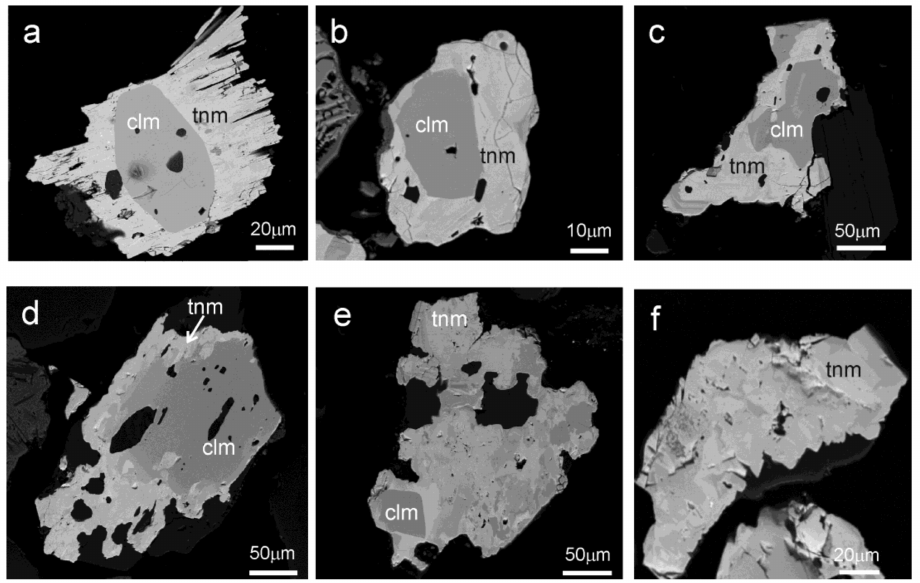
Figure 3. CGM from the Penouta open pit leucogranite showing different textures: ( a – d ), concentric zoning; ( e , f ), patchy zoning. Dark grey, columbite-(Mn); bright grey,